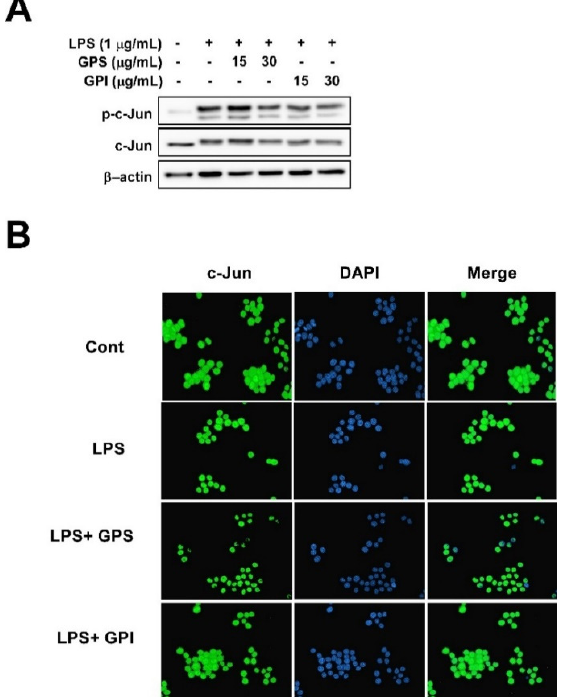
Figure 4. Effects of GPE on LPS-induced phosphorylation of c-Jun and nuclear translocation in RAW 264.7 cells. ( A ) GPEs suppressed the LPS-induced phosphorylation of c-Jun in RAW 264.7 cells. Cells were treated with the indicated concentration of GPE for 1 h and then stimulated with LPS (1 µ g / mL) for 30 min. The levels of phosphorylation and expression were detected by western blot. ( B ) GPE suppressed the LPS-induced c-Jun expression in the nucleus of RAW 264.7 cells. Cells were treated with the indicated concentration of GPE for 1 h and then stimulated with LPS (1 µ g / mL) for 30 min.